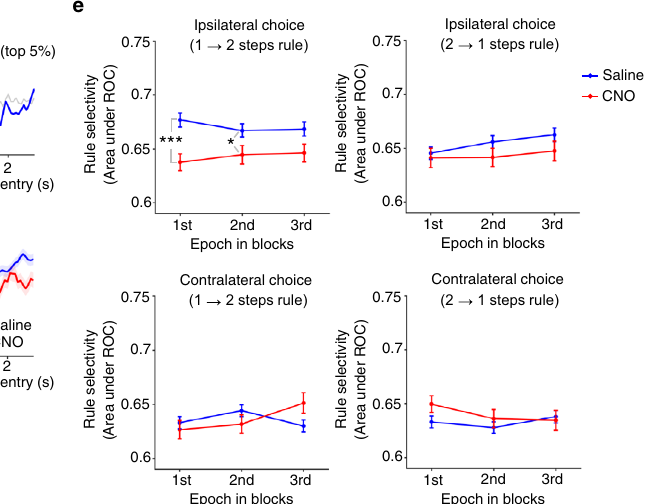
from 1 step to 2 steps rules, i.e., 1st epoch of 2 steps rule blocks (Sup-